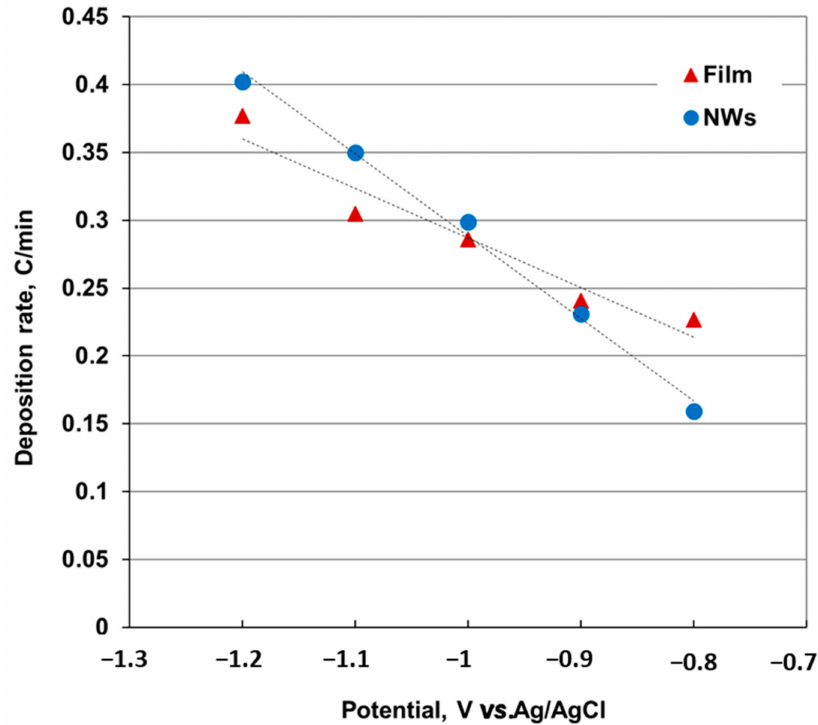
Figure 3. Comparison of the Co-Ni deposition rate for thin films and nanowires at di ff erent deposition potentials (the dotted line indicates the linear trend and is shown only to visually guide the variation of the deposition speed with the applied